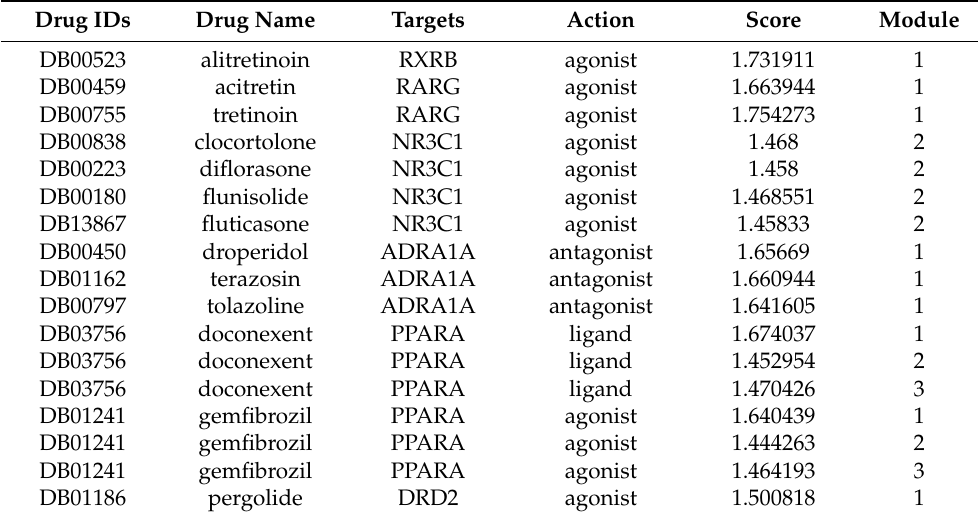
Table 1. Promising candidate drugs for COVID-19